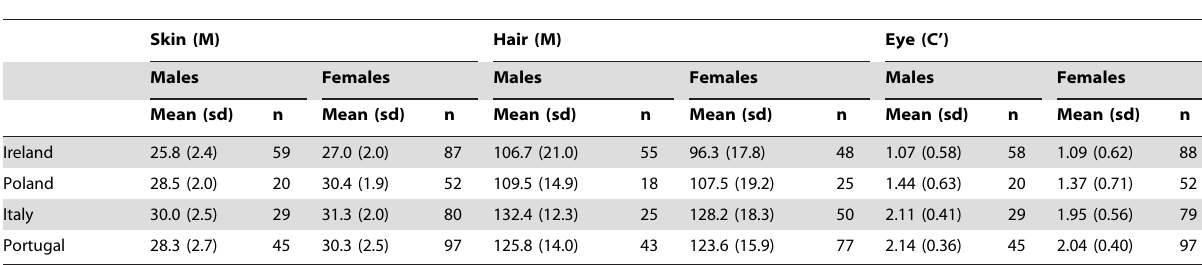
Table 1. Skin, hair, and eye pigmentation by sex and